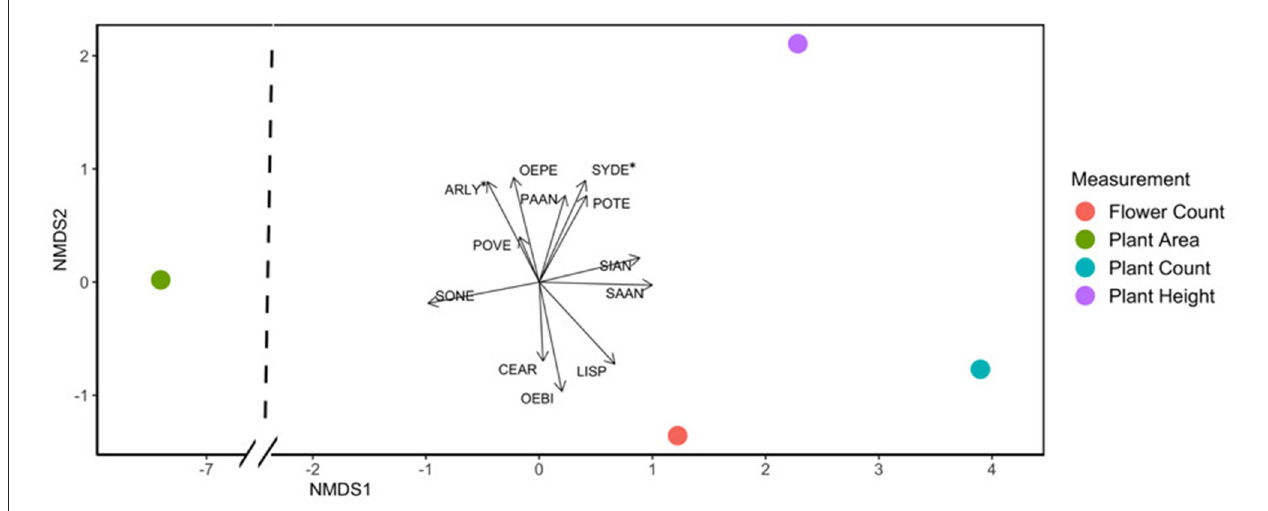
FIGURE 3 | NMDS plot showing that the species Arabis lyrata (ARLY) and Symphyotrichum depauperatum (SYDE) were most affected by deer presence, using an integrated combination of all plant response variables. Points represent average plant response values across species. Length of arrows corresponds to magnitude of the ratio in species response between disturbed and control plots, with longer length indicating greater differences between control and exclusion. Asterisks indicate p values <